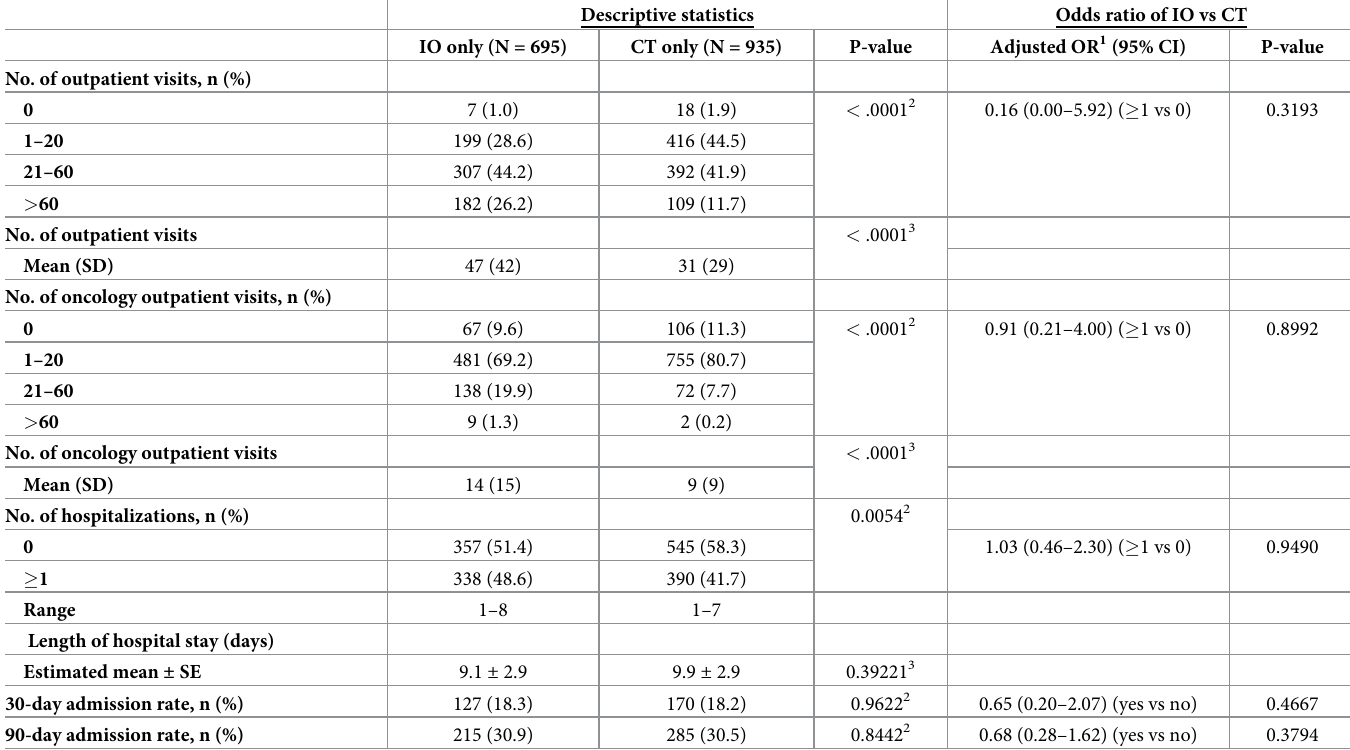
Table 4. Summary of HCRU in 2L